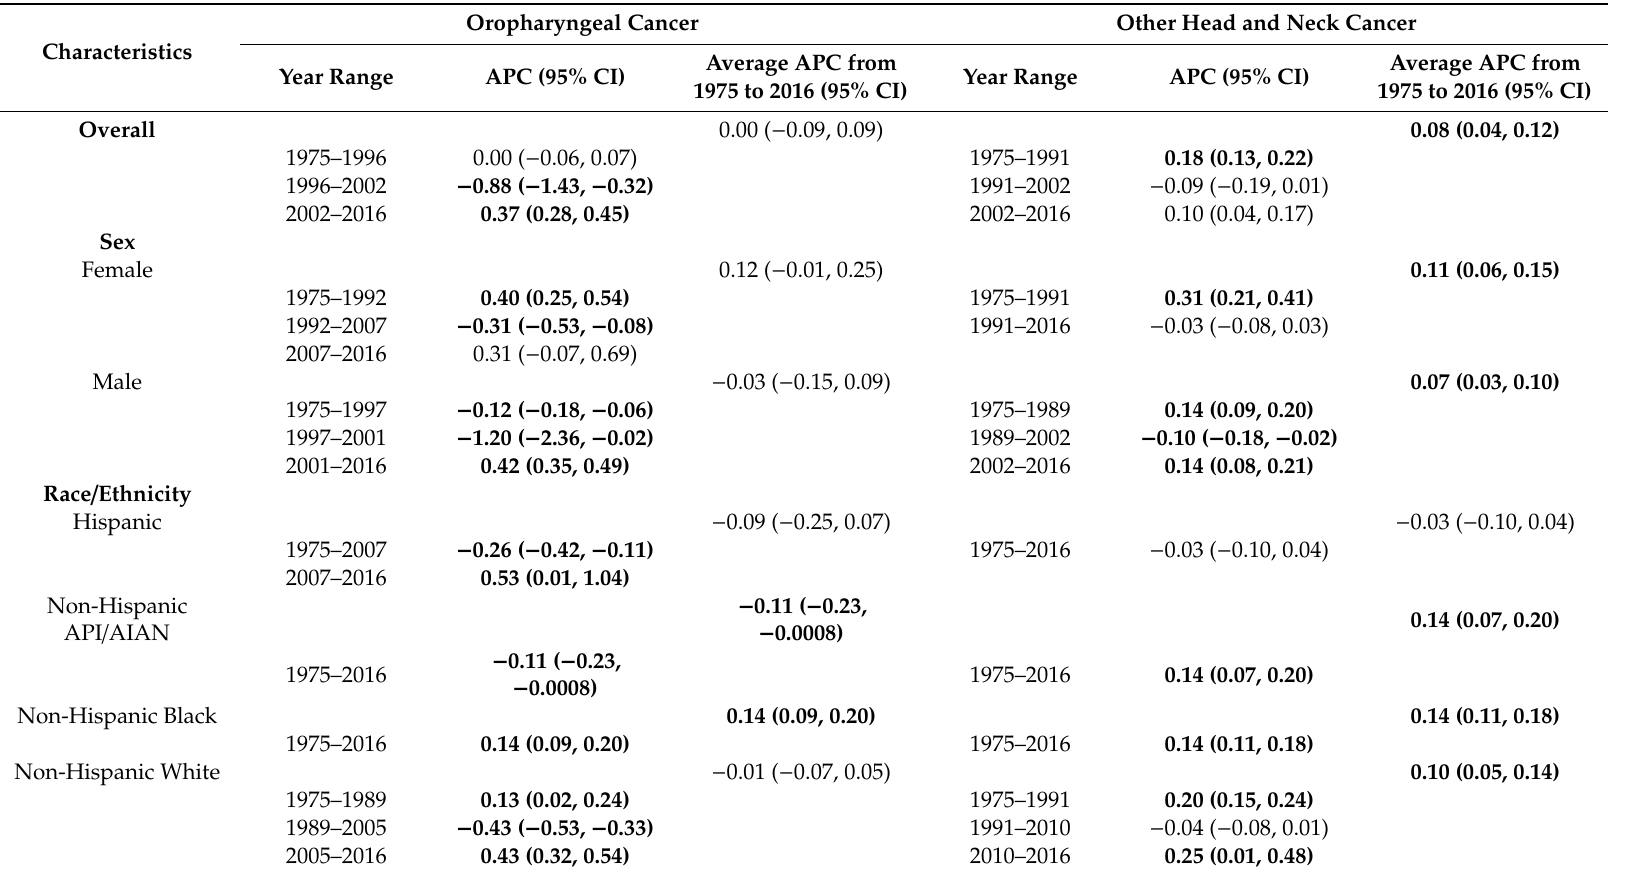
Table 2. Annual percentage changes and average annual percentage changes of average age at diagnosis from 1975 to 2016 by HNC site.